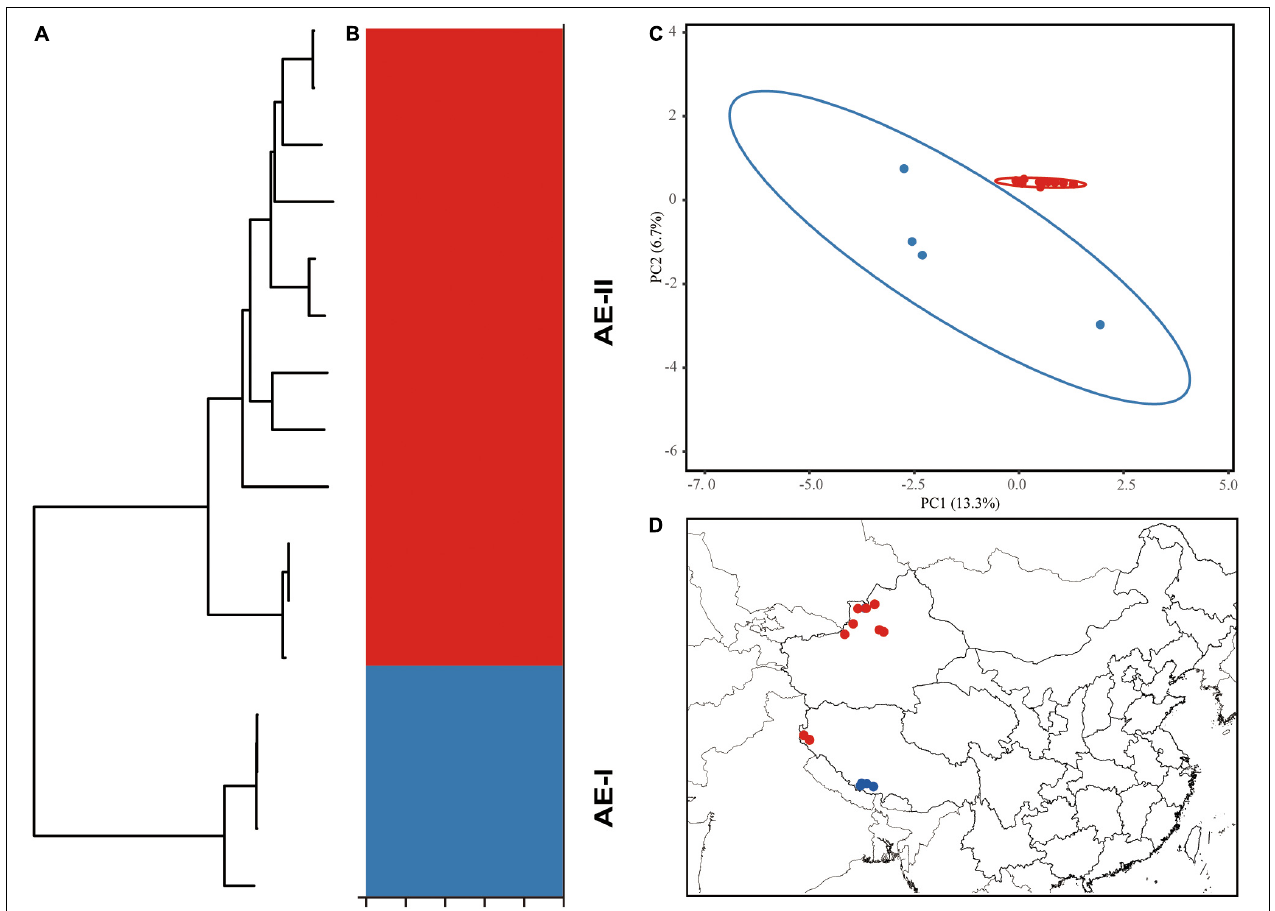
FIGURE 6 | Intraspecific diversity and genetic structure of 15 Arnebia euchroma genotypes based on whole chloroplast genomes. (A) Phylogenetic tree; (B) population structure analysis with K = 2; (C) principal component analysis; (D) geographical distribution